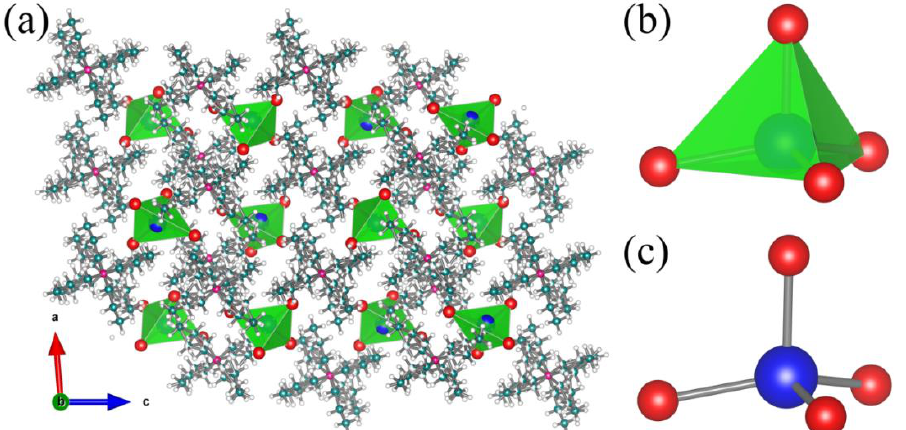
Figure 1. ( a ) Crystal structure of 0D (TPA) 2 PbBr 4 (blue spheres: lead; red spheres: bromine; pink spheres: nitrogen; cyan spheres: carbon; white spheres: hydrogen). ( b ) View of individual tetrahedral clusters [PbBr 4 ] 2− . ( c ) Ball-and-stick diagram of an individual [PbBr 4 ] 2− cluster.